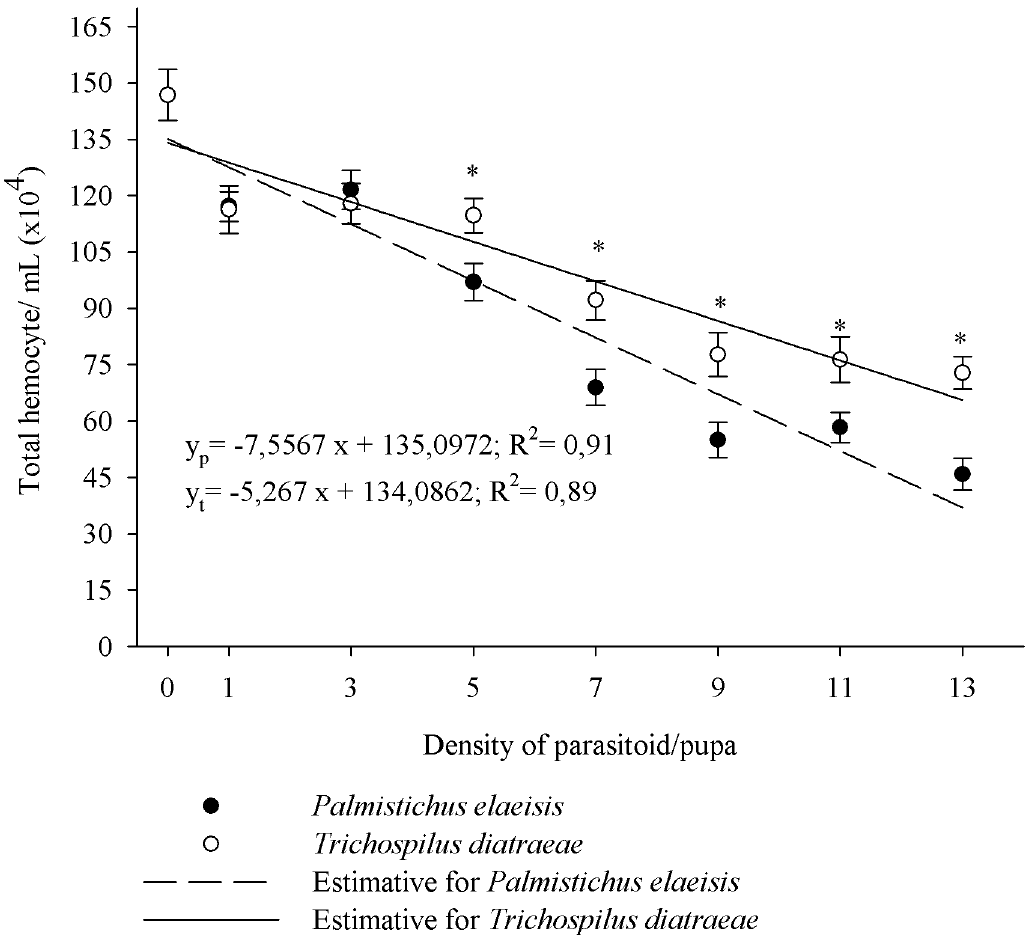
Figure 1. Hemocyte (mean ± se) of Anticarsiagemmatalis pupae parasitized by densities of Palmistichuselaeisis or Trichospilus diatraeae .